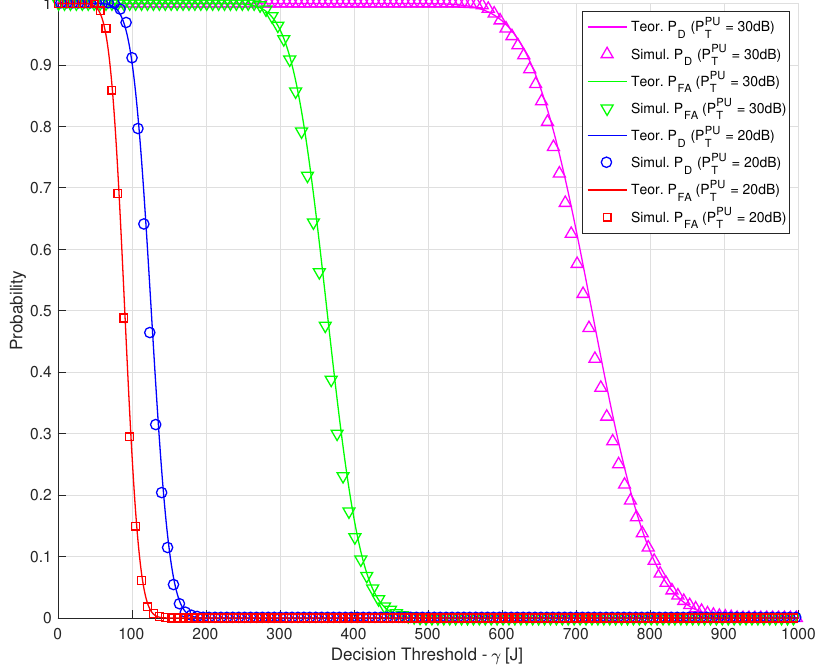
Figure 2. P D , P FA for different thresholds γ and P PU N S = 60 samples , R G = 100 m, R E = 500 m, α = 2, σ ξ =